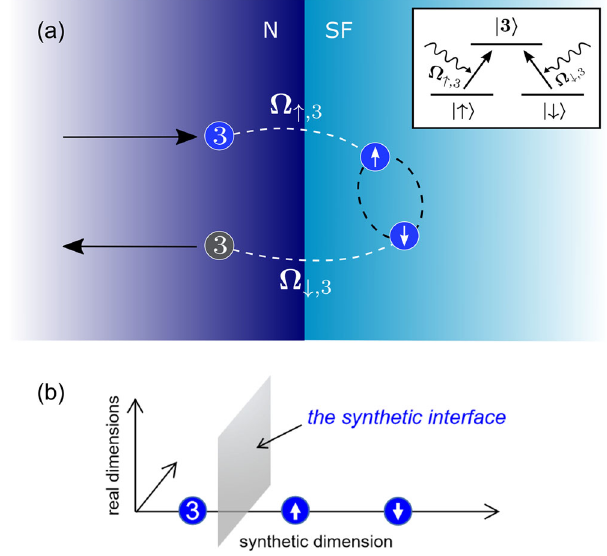
Fig. 1 Schematic of Andreev re fl ection through an synthetic N-S interface. a An incident particle (hole) is retrore fl ected as a hole (particle) into the same normal-state reservoir. The state j 3 i in the normal side interacts with states j "i and j #i in the super fl uid side via the Rabi coupling Ω ↑ Ω ↓ ,3 and ,3 , respectively. The N and SF represents the normal and super fl uid phase. The energy level diagram for the laser-induced state transition is shown in the inset. b The synthetic interface at an extra synthetic